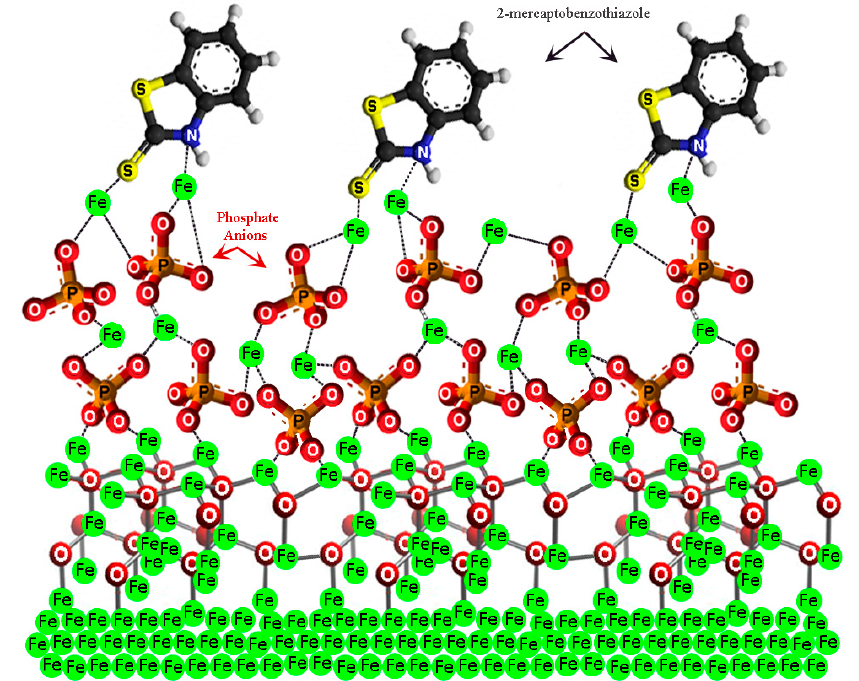
Figure 25. Schematic representation of the phosphate anions and MBT connections onto the mild steel surface, resulting in the formation of the protective